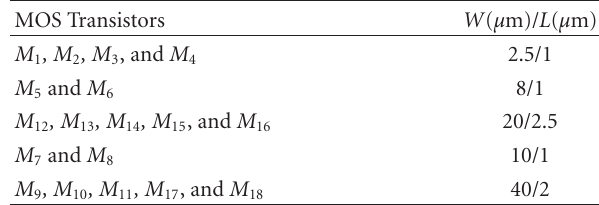
Table 3: Dimensions of the MOS Transistors of Figure